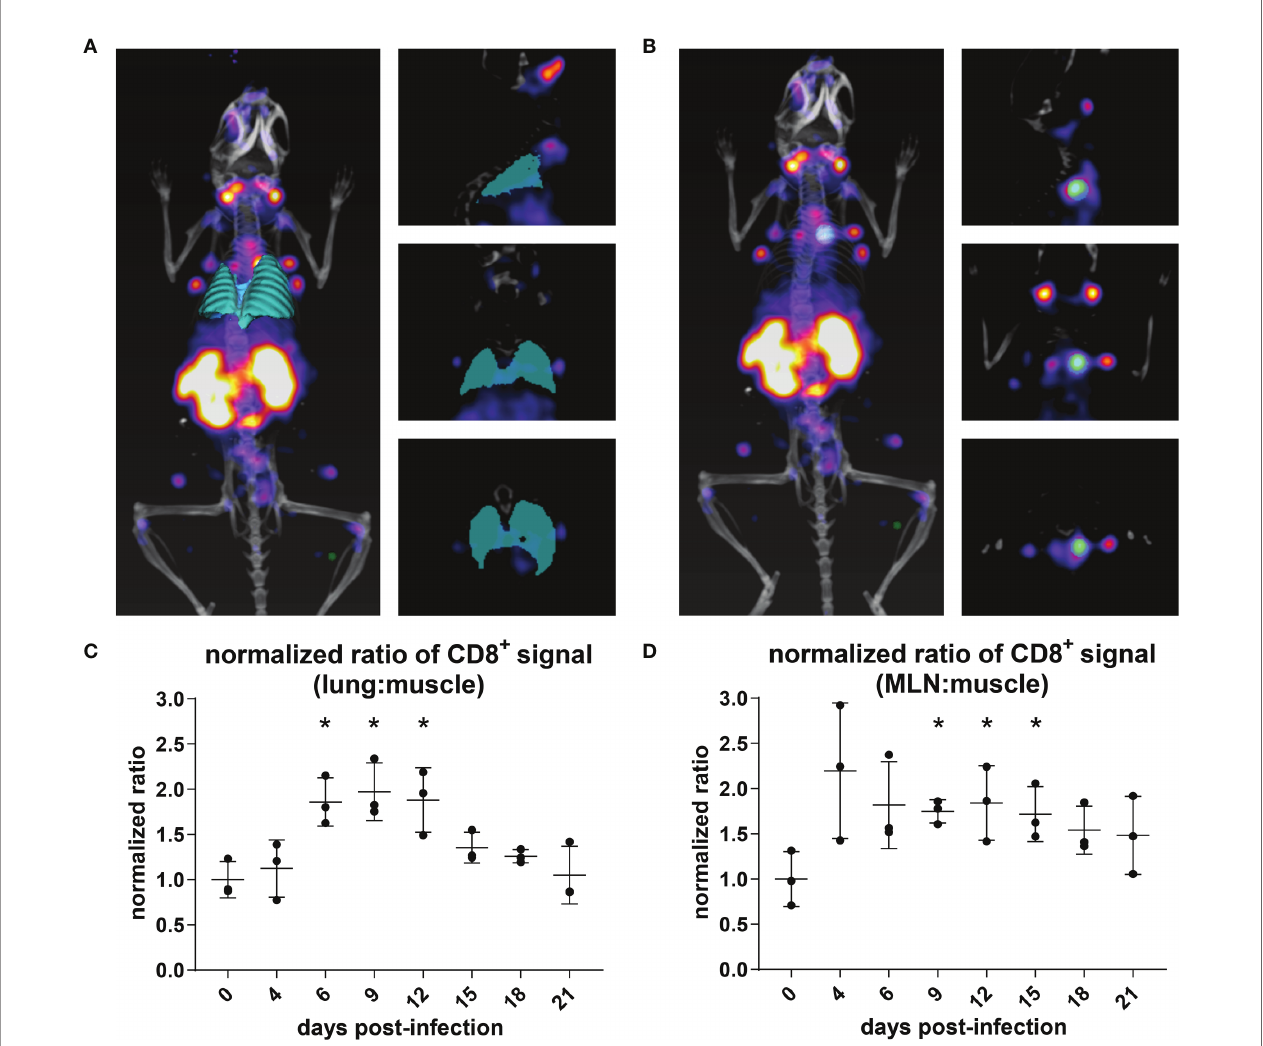
FIGURE 3 | Quanti fi cation of CD8 + T Cell Immuno-PET Signal in the Lungs and MLN/Thymus. (A, B) The volume of the lungs (cyan) was determined using the VivoQuant 3D ROI tool in each mouse based on CT signal (white/grey) (A) . The volume of the MLN (cyan) was de fi ned based on PET intensity (B) . In each mouse, PET intensity was normalized to background signal as de fi ned by a ROI in the quadriceps muscle (green). Mice are shown facing down as 3D renderings (left) and in slices: frontal (top right), sagittal (middle right), and transverse (bottom right) ROI. (C, D) PET intensity from the lung ROI (C) for each day was normalized to the PET intensity of day 0, uninfected mice (n = 3). Student ’ s t-tests were used to compare infected mice at each time point to uninfected mice. *P <